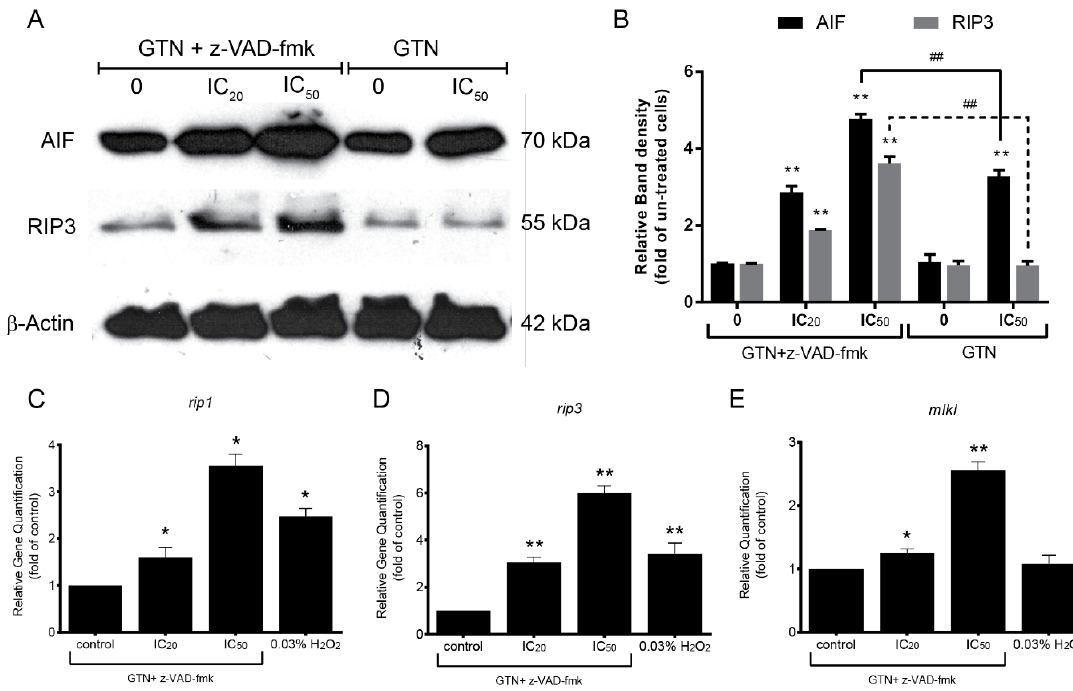
Figure 4. Enhanced necroptosis protein and gene expressions in the GTN and pan-caspase inhibitor-treated MDA-MB-231 cells. The Apoptosis-inducing factor (AIF) and RIP3 protein band density representing protein expression were performed by Western blotting ( A ) and the average band density compared to β -actin, a loading control, was measured by ImageJ software, and the number of folds compared to β -actin are illustrated in the bar graph ( B ). Bar graphs of rip1, rip3 , and mlkl mRNA expressions are demonstrated and normalized with gapdh as a housekeeping gene. The gene expression was performed by SYBR green-based real-time RT-PCR ( C , D, and E ). The data were obtained from three independent experiments in triplicate, the significance of statistical values compared to the z-VAD-fmk-treated alone group are marked with * p < 0.05; ** p < 0.01 and compared to the GTN alone group are marked with ## p < 0 . 01.